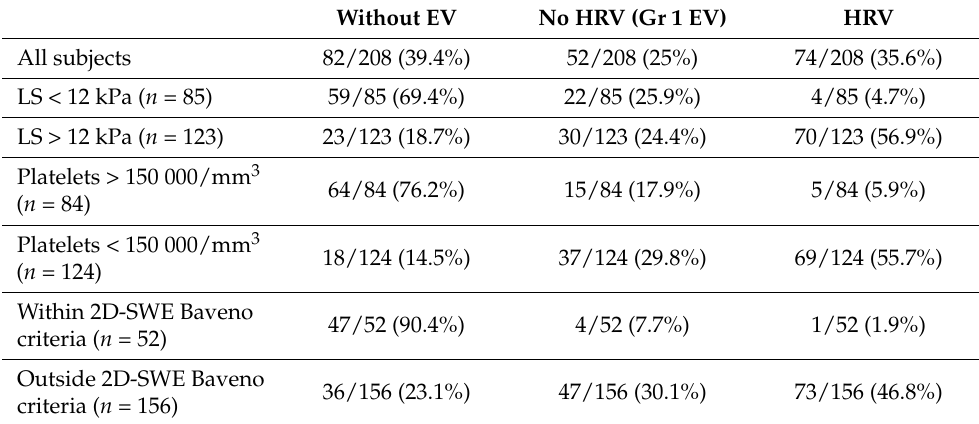
Table 2. Distribution of subjects according to